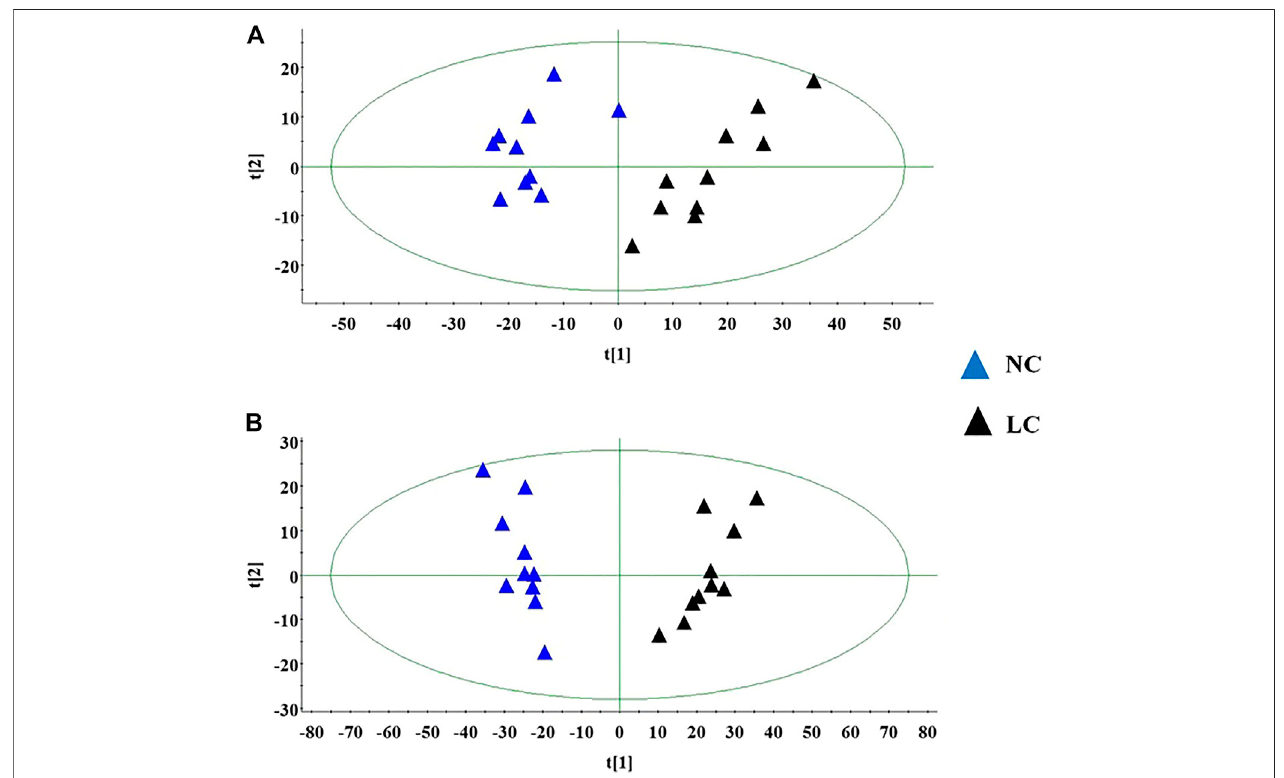
FIGURE 3 | The score plot of the PCA model between NC and LC group in positive ion mode (A) ; The score plot of the PCA model between NC and LC group in negative mode (B) .